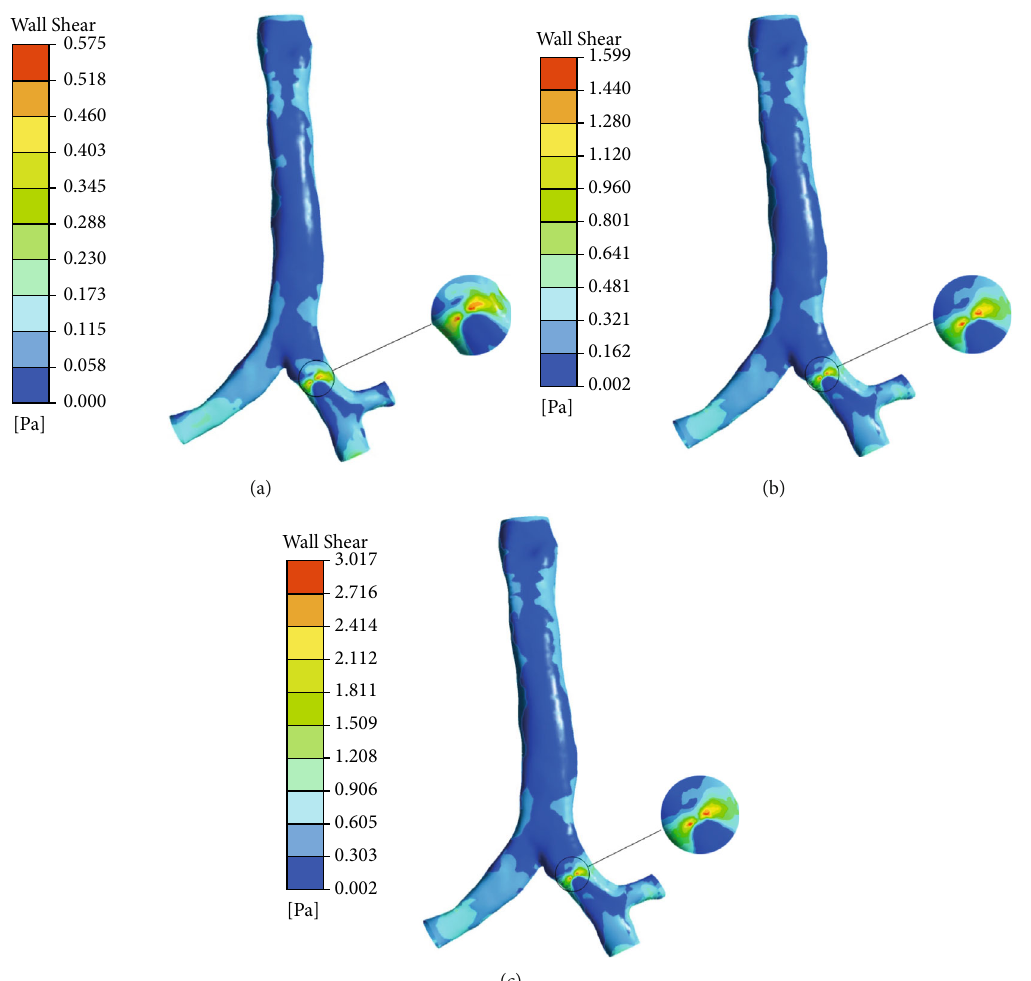
Figure 12: Wall shear for the three lung models at (a) 2.1326m/s, (b) 4.2653 m/s, and (c)